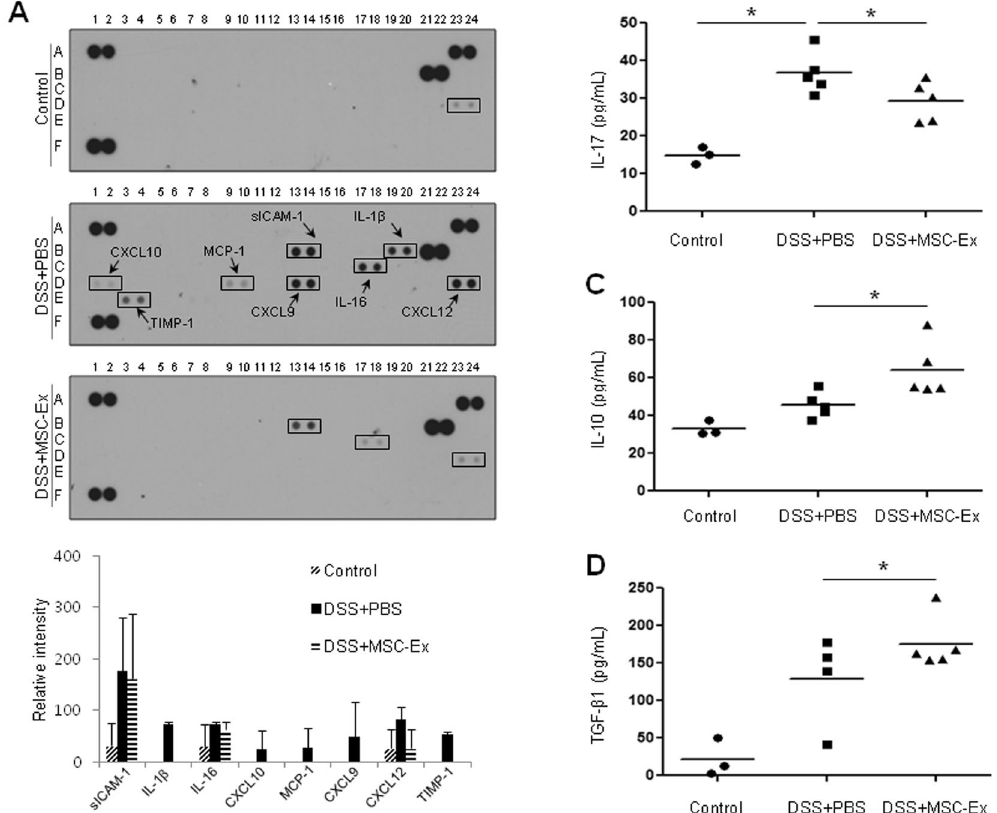
Figure 3. MSC-Ex decreases the expression of pro-inflammatory cytokines in chronic DSS-induced colitis. (A) The levels of inflammation-related cytokines were analyzed using colonic tissues by immunoblot analysis (top). The relative expression of each cytokine was quantified (bottom); data representative of those obtained in three independent experiments are shown. The levels of IL-17 (B) , IL-10 (C) , and TGF- β 1 (D) in colon extracts were measured by ELISA in the colons of chronic colitis-induced mice at necropsy on day 36 following DSS exposure. Data are represented as the means ± s.d. ( n ≥ 5 ). * P < 0.05, ** P < 0.005, *** P < 0.001